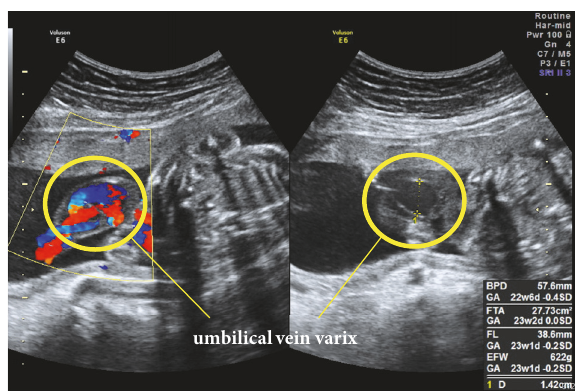
Figure 1: Ultrasonogram at 23 weeks of gestation shows abnormal bean-like dilation of the umbilical vein.